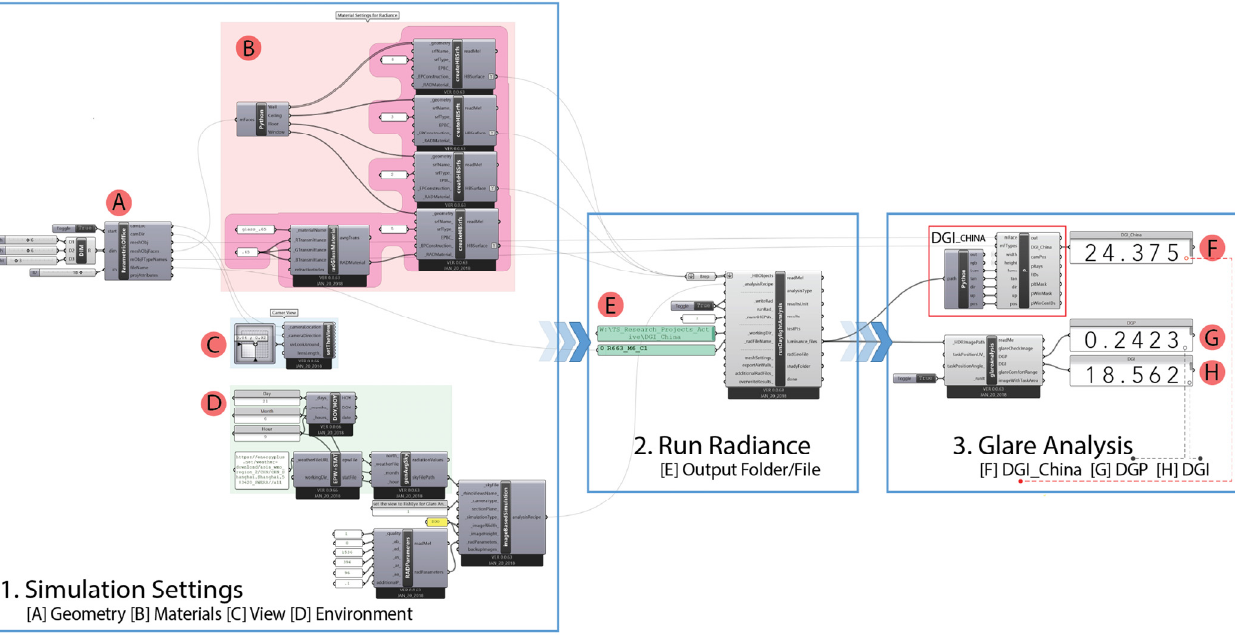
Figure 4. The computational procedure implemented in Grasshopper3D.